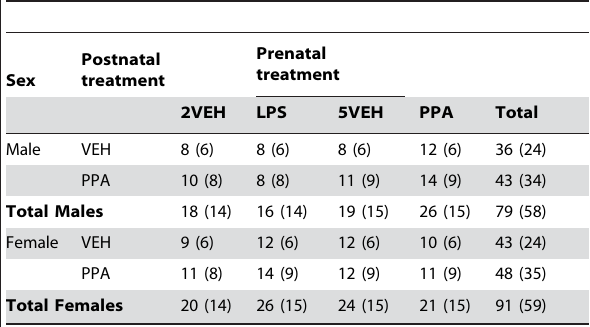
Table 1. Number of animals in the treatment groups used for developmental milestones and behavioral